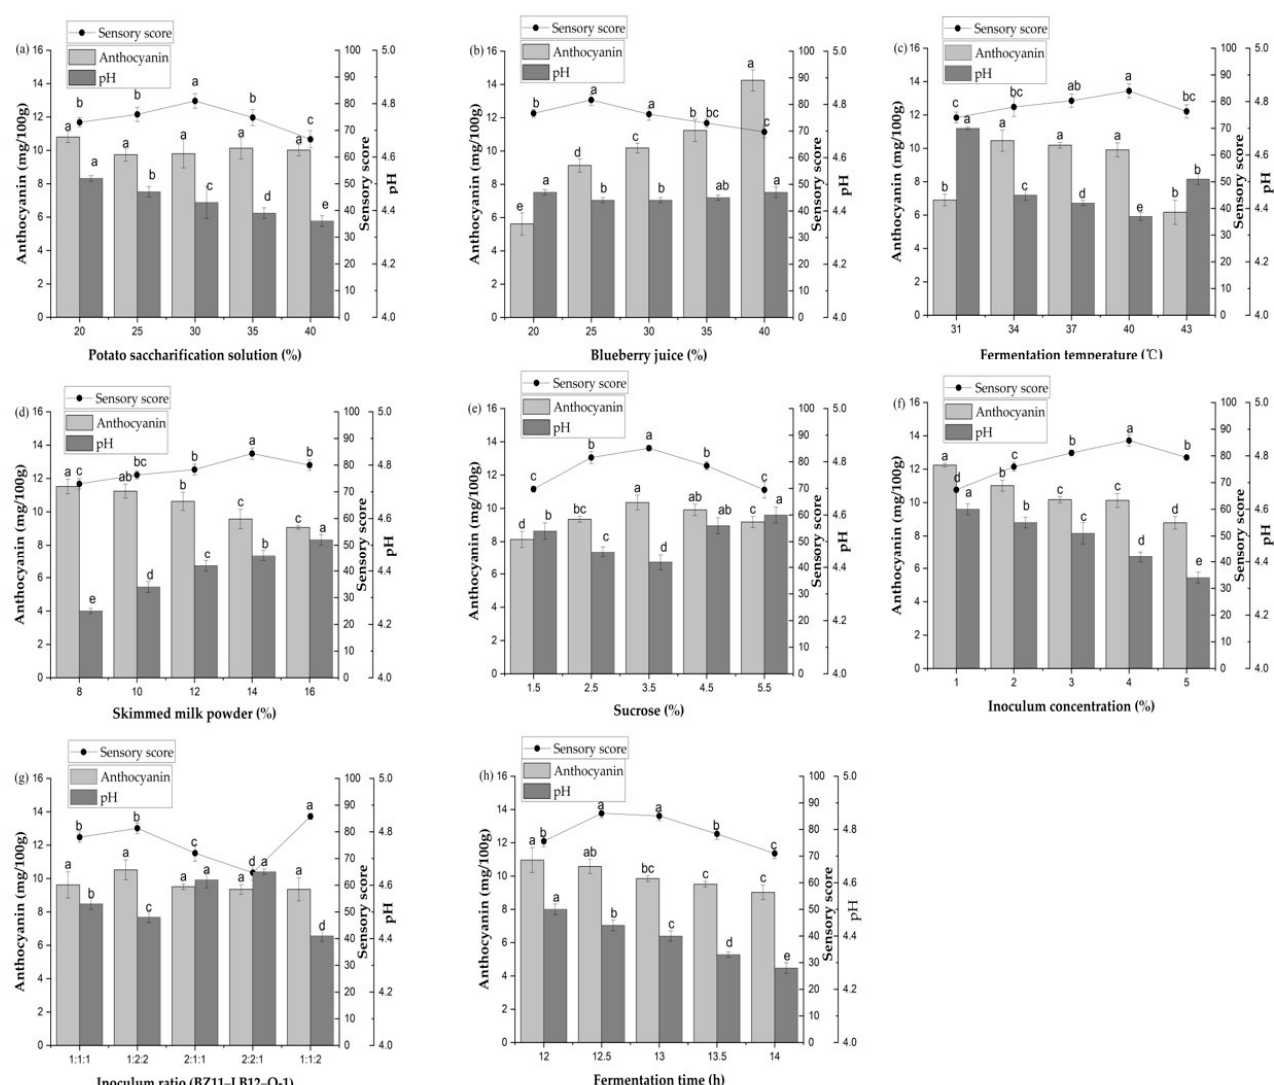
Figure 1. Effect of potato saccharification solution ( a ), blueberry juice ( b ), fermentation temperature ( c ), skimmed milk powder ( d ), sucrose ( e ), inoculum concentration ( f ), inoculum ratio ( g ), and fermentation time ( h ) on the sensory value, pH, and anthocyanin of potato blueberry yogurt. Different letters above each bar mean significant differences.